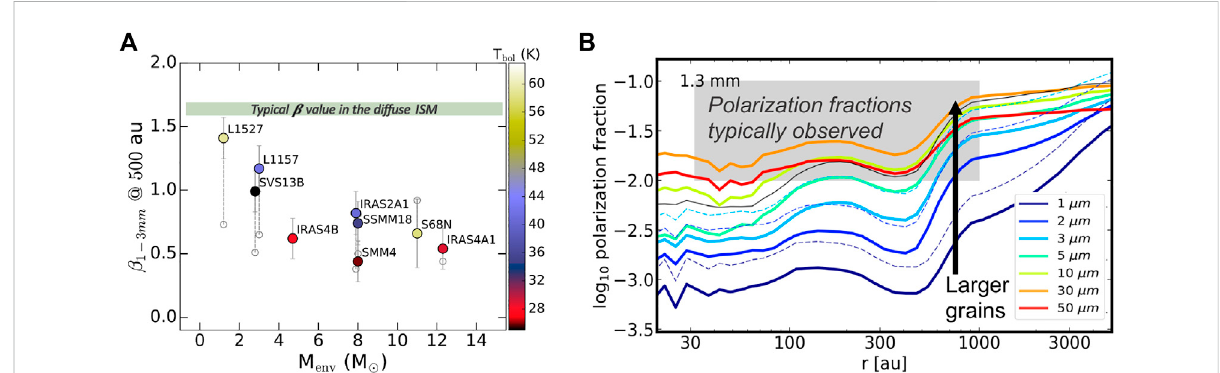
FIGURE 2 (A) Observed millimeter dust emissivity index in a sample of young protostars (Galametz et al., 2019). All protostellar envelopes probed at radii ~ 500 au show lower values than the progenitor diffuse ISM. (B) Radial pro fi le of the polarization fraction from the 1.3 mm dust emission predicted fromRATalignmentofdustgrainsinatypicallow-massprotostellarenvelope(Valdiviaetal.,2019).Large( > 10 μ m)dustgrainsarerequiredtomatch the observations of the polarized emission (gray